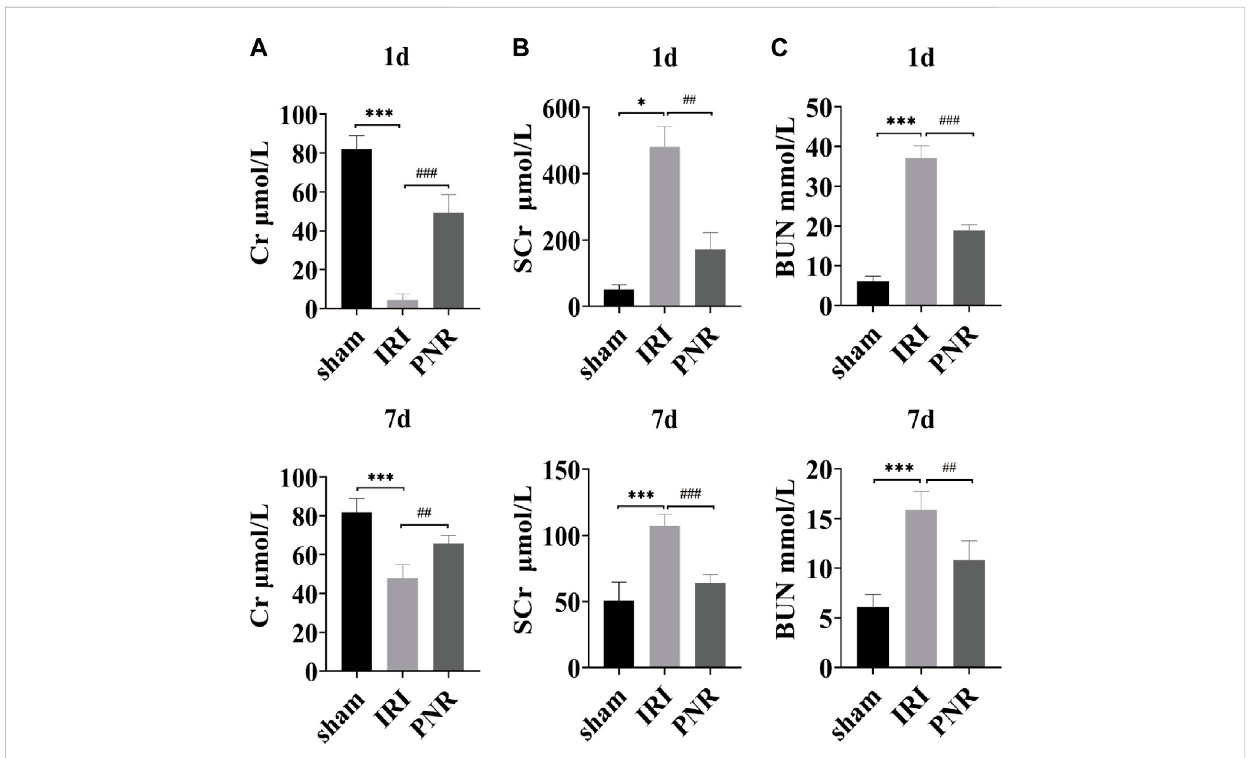
FIGURE 1 Results oftheeffect ofPNR pretreatmenton urine and blood biochemical indexesatdays 1and 7 postoperatively. (A) Cr content ineach group (N = 4 – 6); (B) SCr content in each group (N = 3 – 7); (C) BUN content in each group (N = 4 – 7). Compared with the sham group, *** p < 0.001, * p < 0.05; compared with the IRI group, ### p < 0.001, ## p <